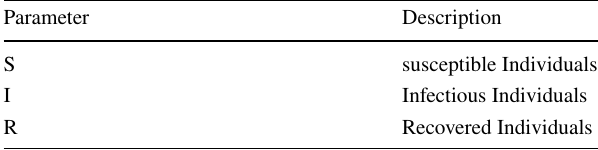
Table 1 Demonstration of state variables of SIR model Parameter Description